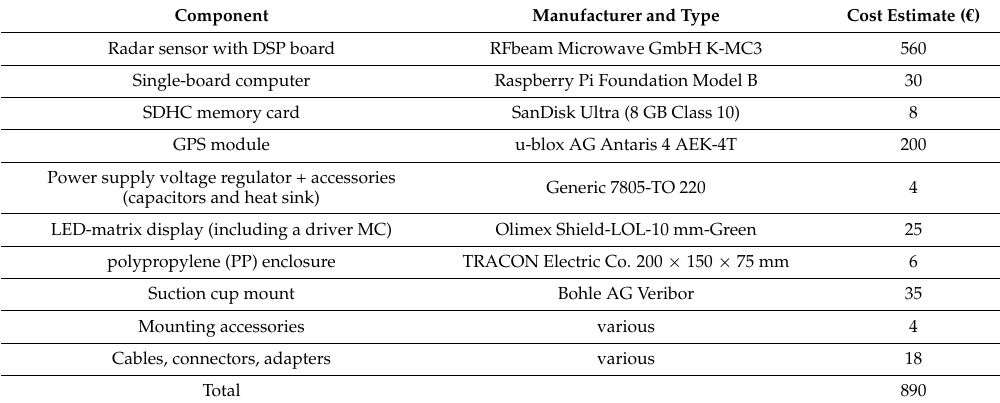
Table 2. The components used in the final